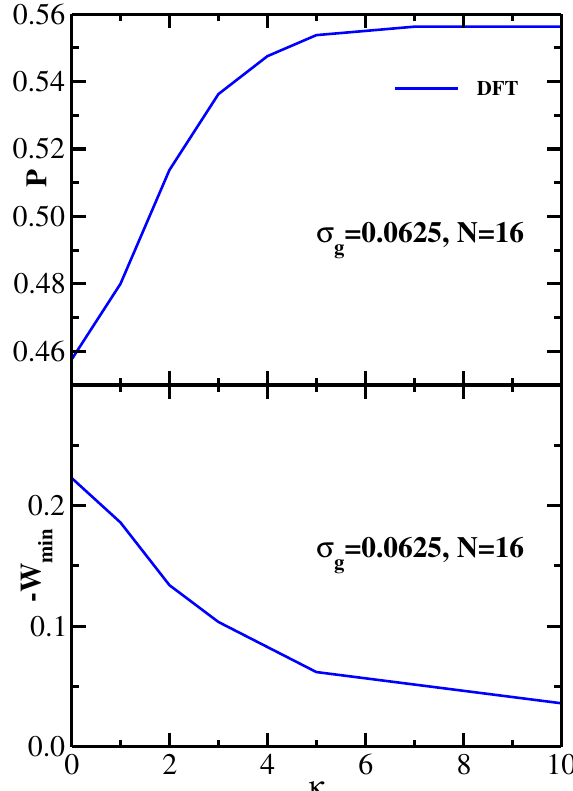
Figure 4. Upper panel: DFT results for the overlap P as a function of the grafted chain stiffness parameter κ for two monodisperse semiflexible brushes at equilibrium separation H ; grafting density is σ g = 0.0625 and grafted chain length is N = 16. Lower panel: DFT results for the (negative) minimum of the PMF between two monodisperse semiflexible brushes as a function of the grafted chain stiffness parameter κ